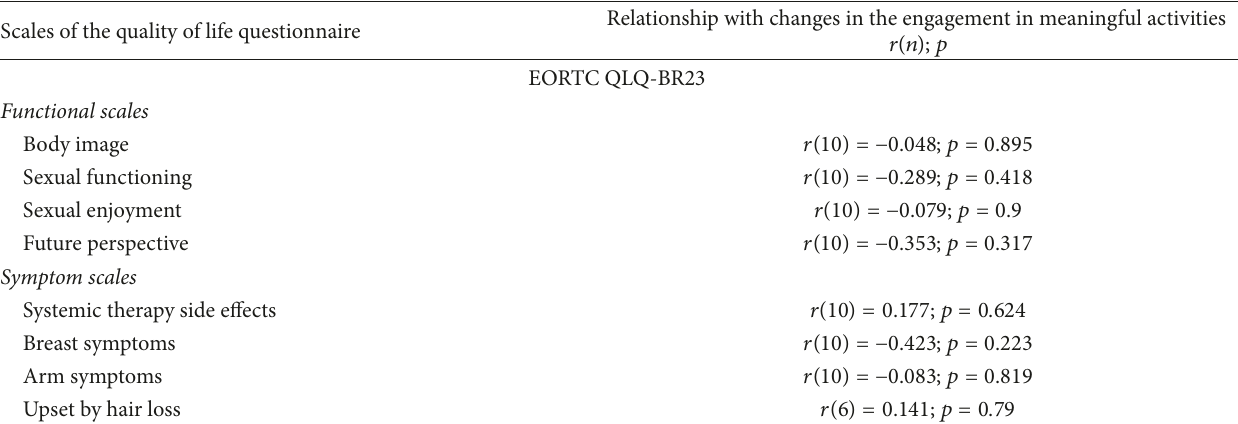
Table 7: Relationship between engagement in meaningful activities and evaluations scores of health-related quality of life (EORTC QLQ- BR23) in women with breast